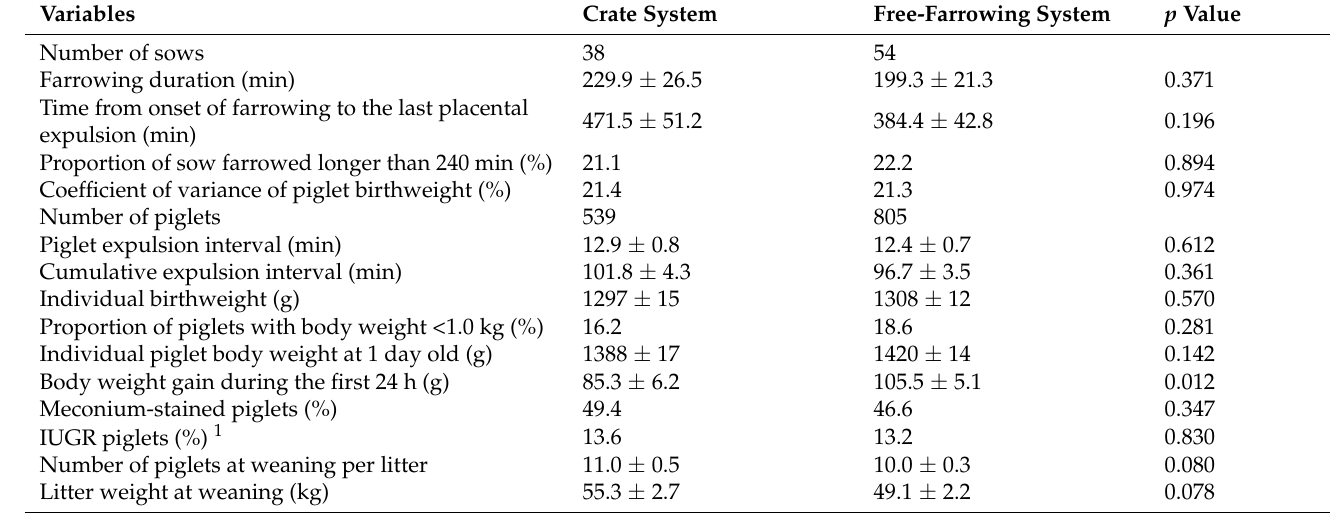
Table 3. Farrowing performance and piglet characteristics in the litters in the crate system compared to the litters in the free-farrowing system in a tropical environment (Lsmeans ± SEM).